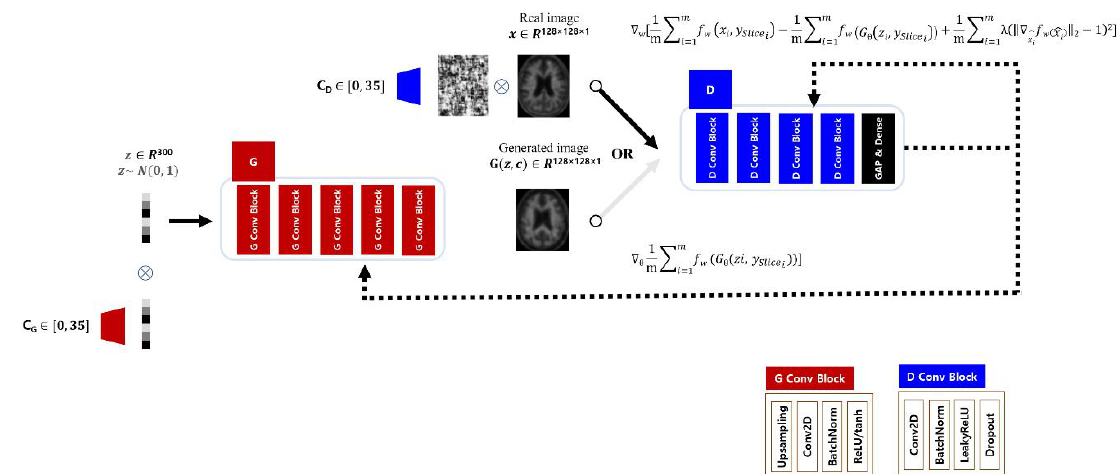
Figure 3. Structure of generative adversarial network to enhance data for a specific disease. The amyloid negative or positive dataset were used for training independent generator (G) and discriminator (D) with a condition indicating an axial level label (C G and C D ).